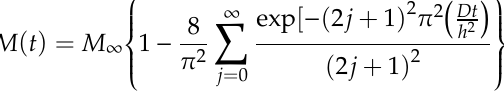
Figure 13. Typical model of water absorption of composites: ( a ) Fick model; ( b ) Two ‐ stage model.